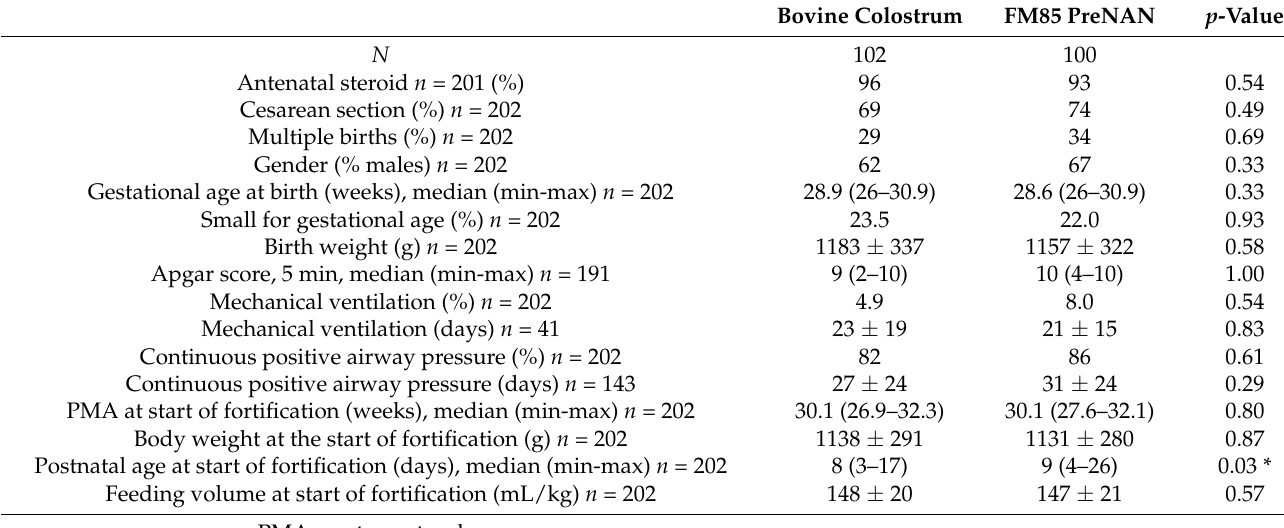
Table 2. Baseline characteristics of included infants (percentage, median min-max or means ± SD).